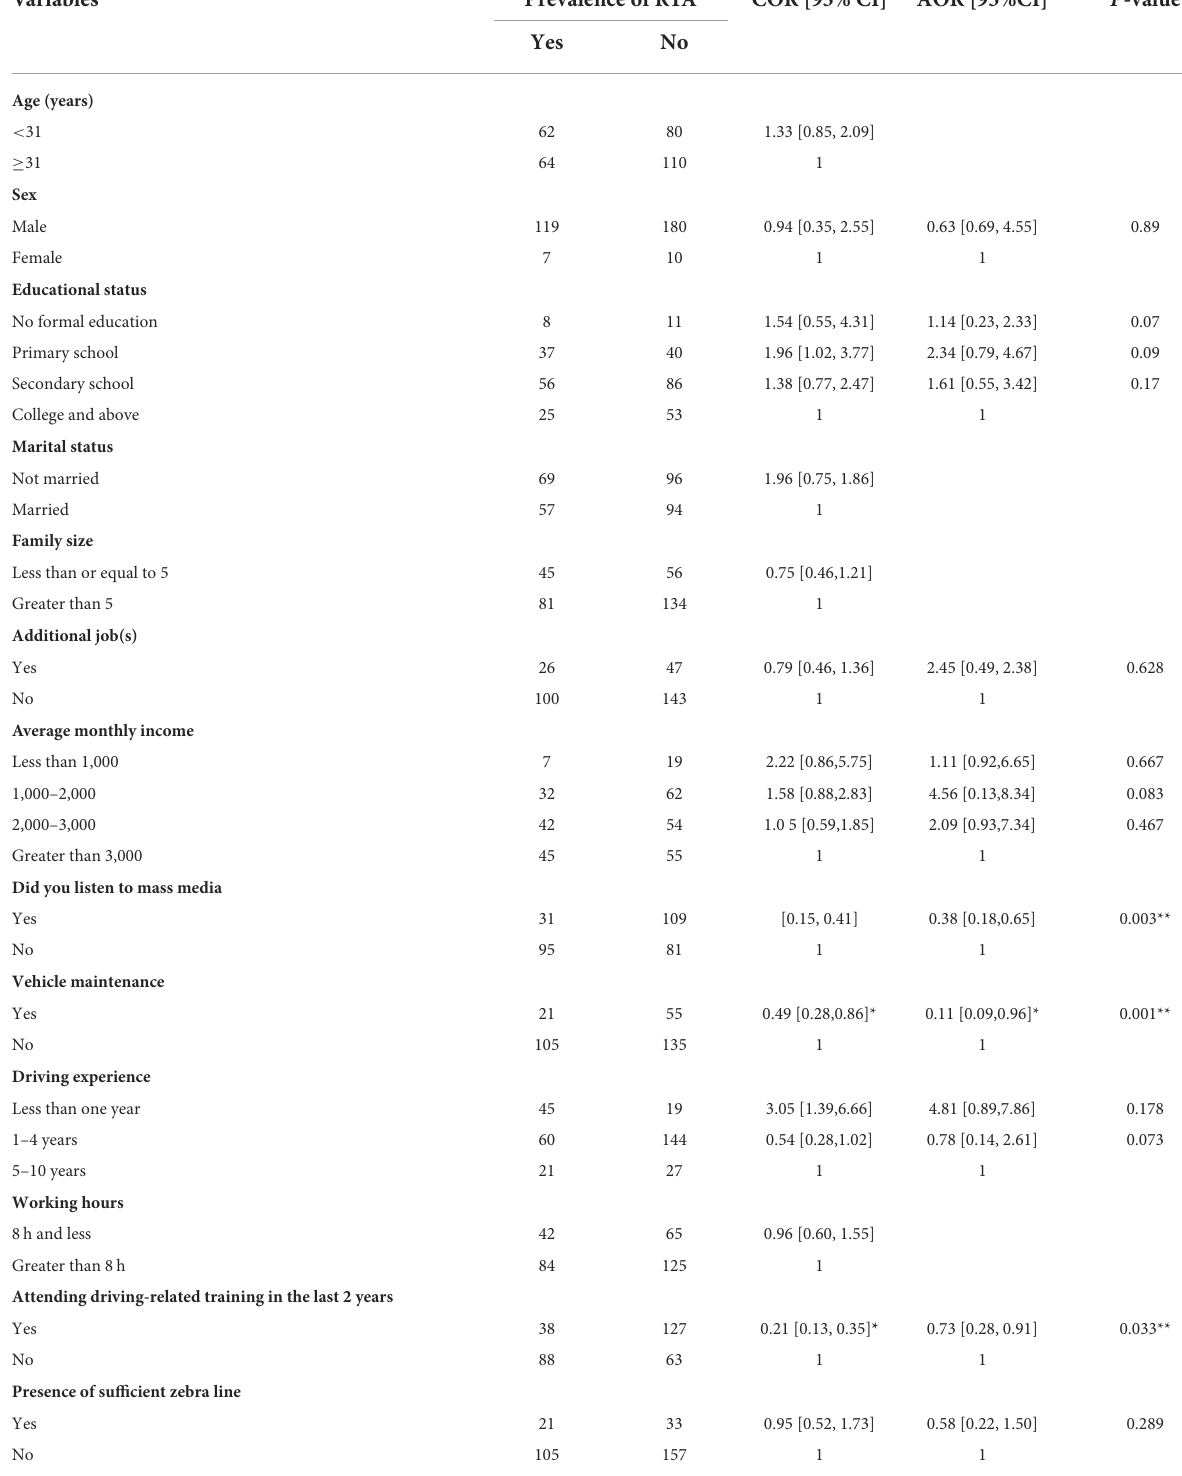
TABLE 3 Factors associated with road traffic accidents among vehicle drivers in Dilla Town, Gedeo Zone, Southern Ethiopia, 2021 (n = 316). Variables Prevalence of